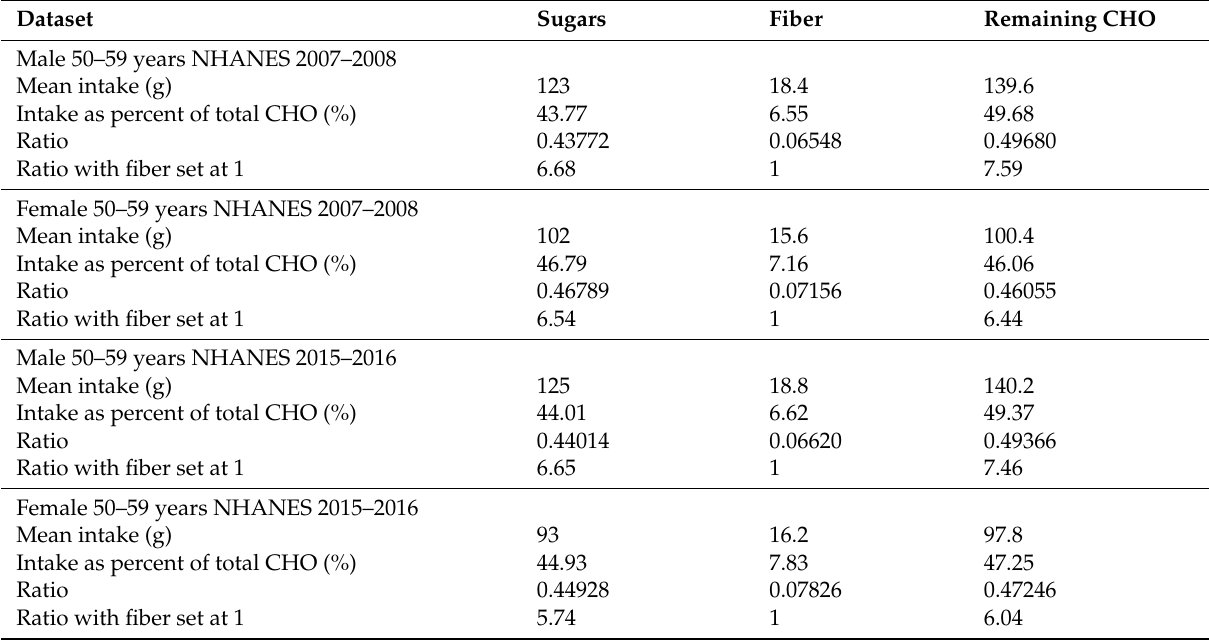
Table 5. The mean NHANES intake (derived from the National Health and Nutrition Examination Survey (NHANES) 2007–2008 and 2015–2016 data) of sugars, fiber, and the remaining carbohydrates, their ratios, and their ratios relative to fiber for males and females 51–59 years of